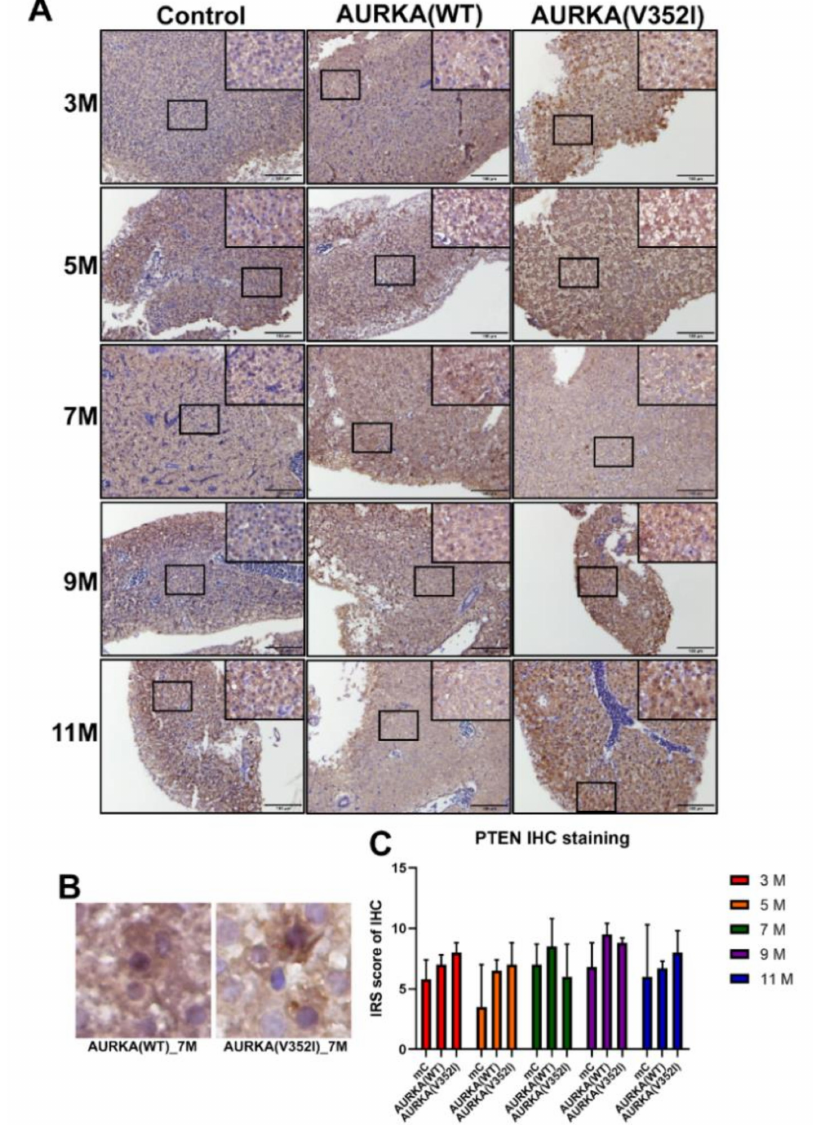
Figure 9. Immunoreactive score of the phosphatase and tensin homologues deleted on chromosome 10 (PTEN). Immunostaining reveals that PTEN shows no di ff erence between control and AURKA transgenic zebrafish. ( A ) Representative images of immunohistochemistry (IHC) staining for PTEN in control, AURKA(WT), and AURKA(V352I) at 3, 5, 7, 9, and 11 months; ( B ) Selected enlarged images show the PTEN signals from AURKA(WT)—7 M and AURKA(V352I)—7 M; ( C ) Statistical analysis of PTEN immunostaining IRS score at 3, 5, 7, 9 and 11 months. IRS score of control fish (Tg(fabp10a:EGFP-mCherry) abbreviated as mC, AURKA(WT) and AURKA(V352I) is shown in red (3 M), orange (5 M), green (7 M), purple (9 M), and blue (11 M). Statistical analysis of results was performed using a two-tailed Student’s t -test. The error bar means standard